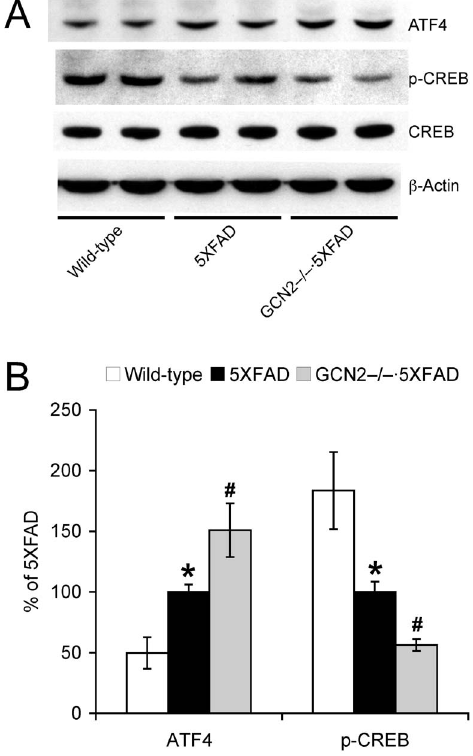
Figure 4. Effects of GCN2 deletion on ATF4 and CREB pathways in 5XFAD mice. (A) Representative immunoblots of protein extracts from hippocampal homogenates of mice. (B) Immunoreactive bands were quantified and expressed as the percentage of 5XFAD control mice ( n =6–8). Note that GCN2 2 / 2 deletion further increases ATF4 expression and accordingly reduces levels of phosphorylated CREB without affecting total CREB in 5XFAD mice. * p , 0.05 vs. wild-type, # p , 0.05 vs. 5XFAD. All data are presented as mean 6